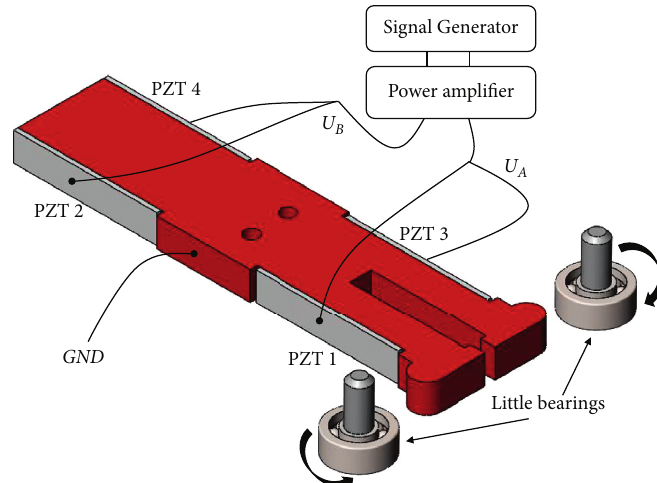
Figure 13: Test principle of stator driving